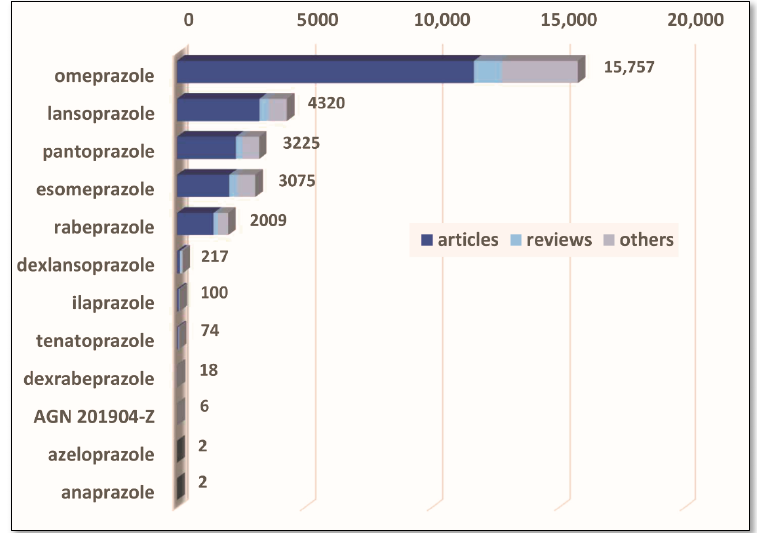
Figure 3. Number of articles, and other items published on proton pump inhibitors in the years 1990–2022 (source: Web of Science Core Collection).